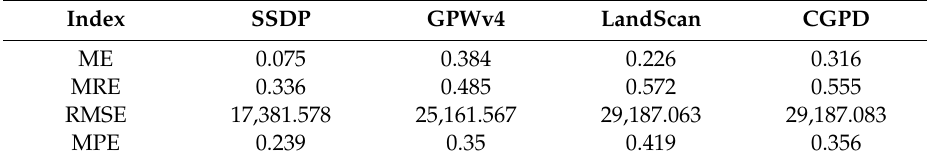
Table 5. Comparison of accuracy in four population grids.